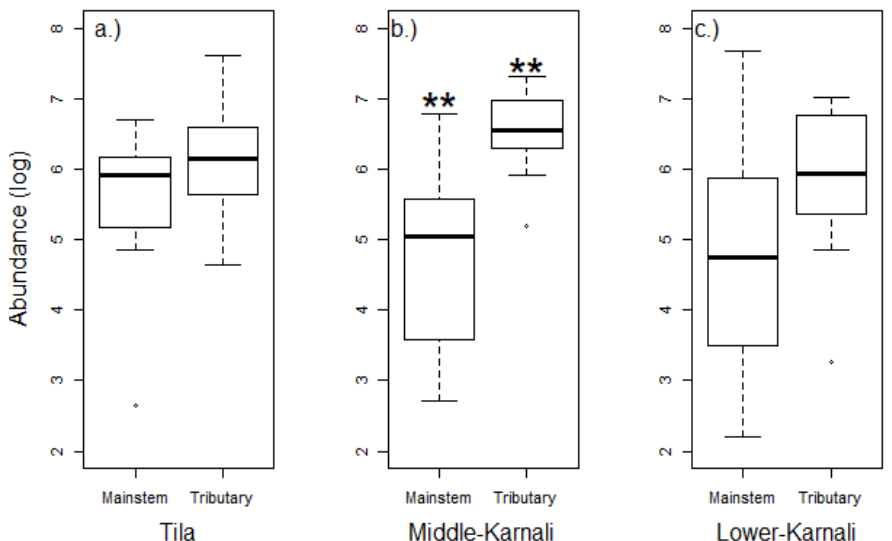
Figure 3. Benthic macroinvertebrate abundance (log transformed) in the river’s mainstem and the tributaries in the three selected watersheds (( a ). Tila, ( b ). Middle-Karnali, ( c ). Lower-Karnali) of the Karnali River Basin. Each boxplot shows the median value (black line), the 25th and 75th percentiles (rectangle edges), the min and max values (vertical lines) and the outliers (white circles). **Differences are significant at the p < 0.01 level.